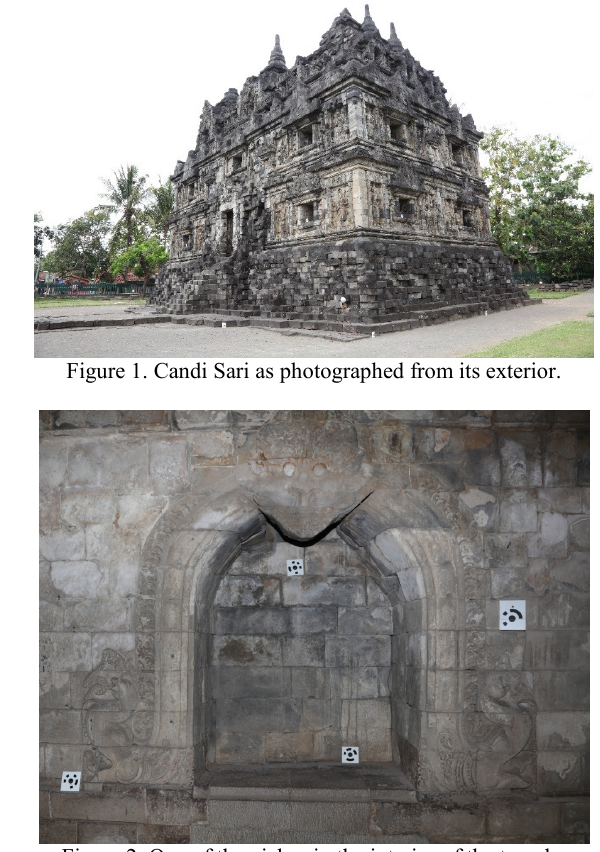
Figure 2. One of the niches in the interior of the